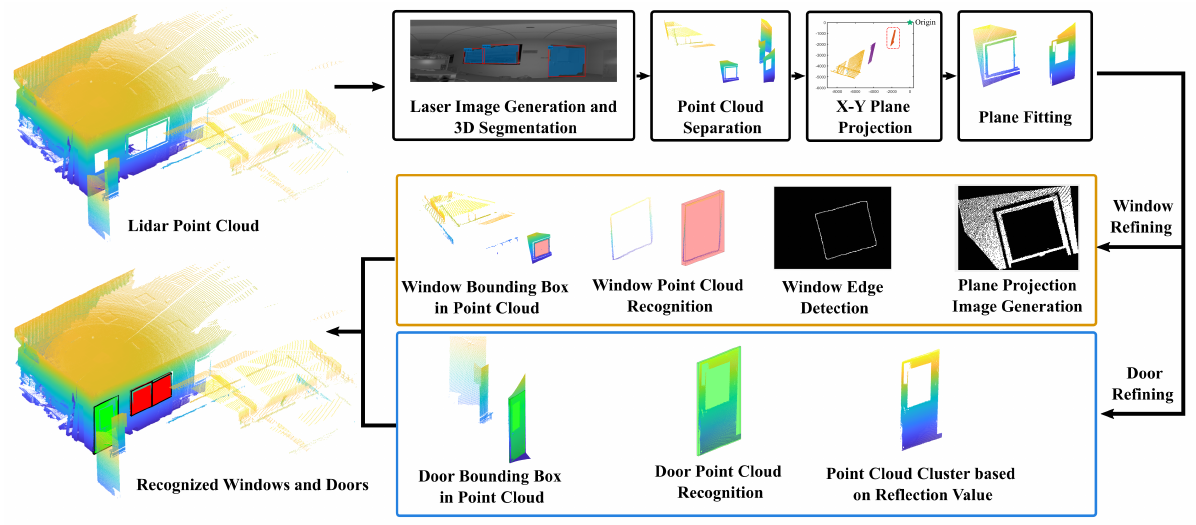
Figure 2. The procedure of windows and doors’ bounding-box detection from the point